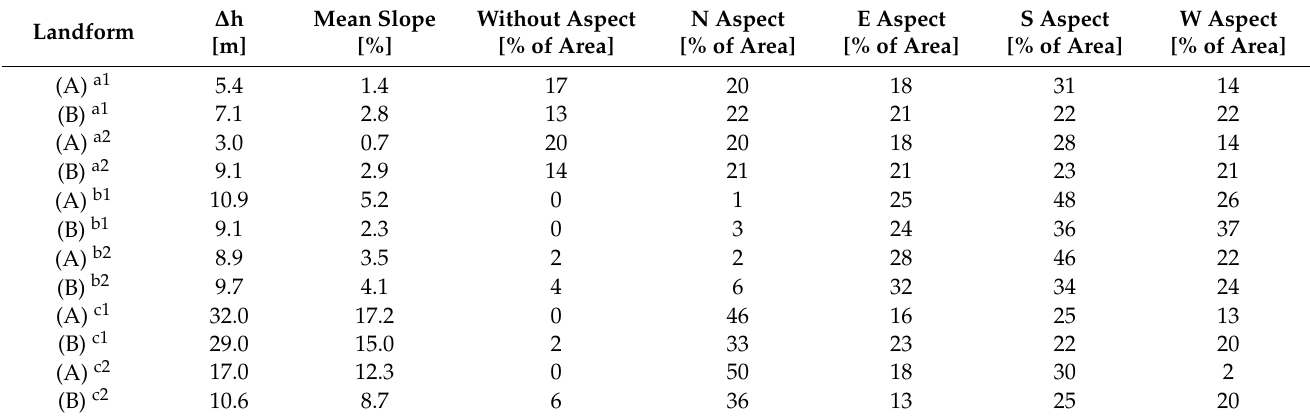
Table 4. Topographic parameters of lower rank landforms (a1, a2), (b1, b2), (c1, c2) in time variant (A) and (B) based on the fourth method.